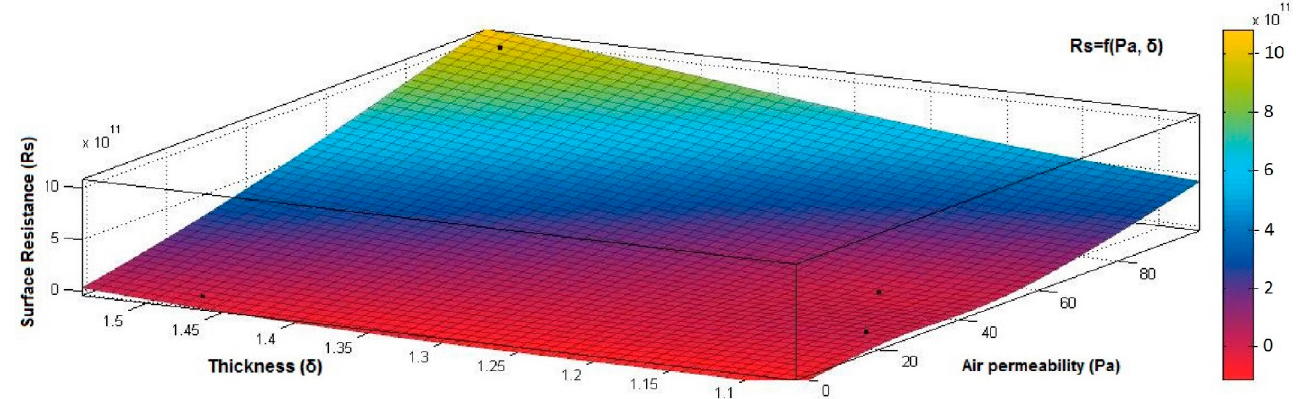
Figure 18. 3D representation Rs = f( δ , Pa ) samples coated with a conductive polymeric paste ‐ based PVDF.